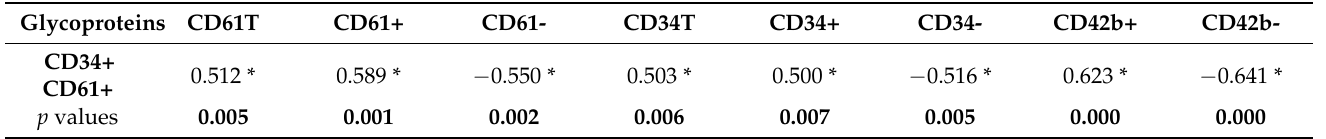
Table 7. Correlations between glycoprotein levels implied in cell proliferation.